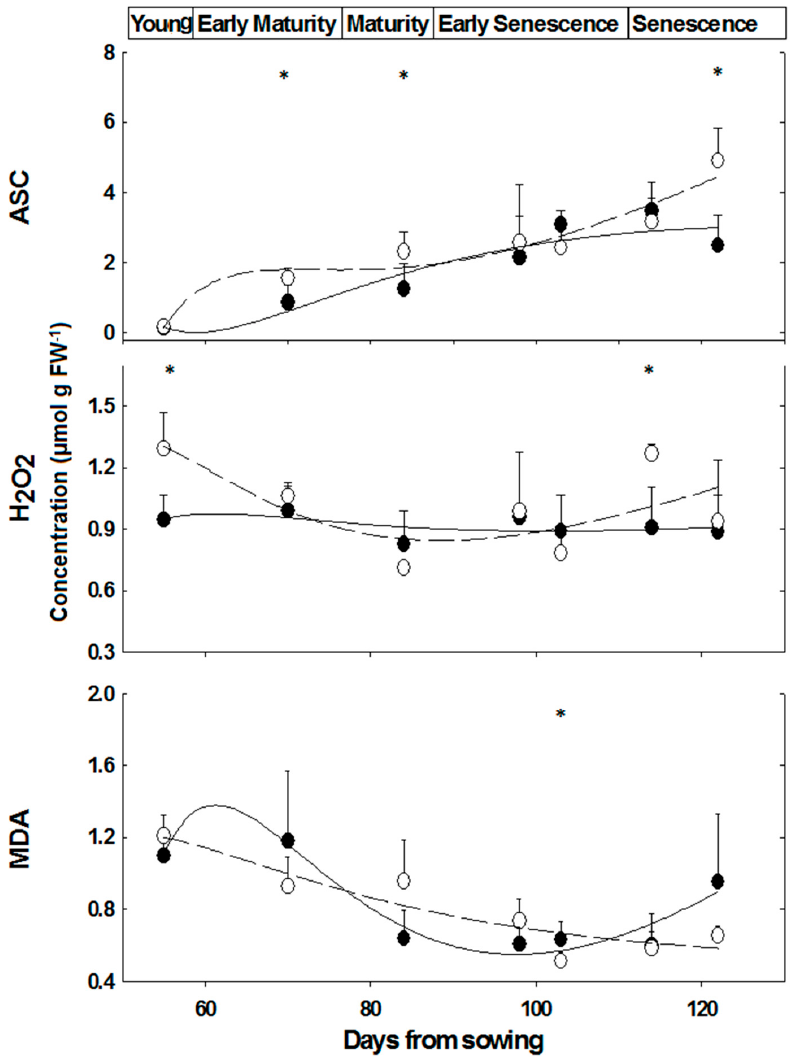
Figure 4. Ascorbate, hydrogen peroxide and MDA concentrations in leaves of M. annua female and male plants during development. Plants were grown in soil without salt and at the indicated time points were harvested for analysis as indicated in the Experimental Section. The data were fitted by a 3rd order polynomial curve. Ave ˘ SD, n = 3. Open circle—female plant; Black circle—male plant. * indicate significant difference ( p < 0.05) between female and male at a given